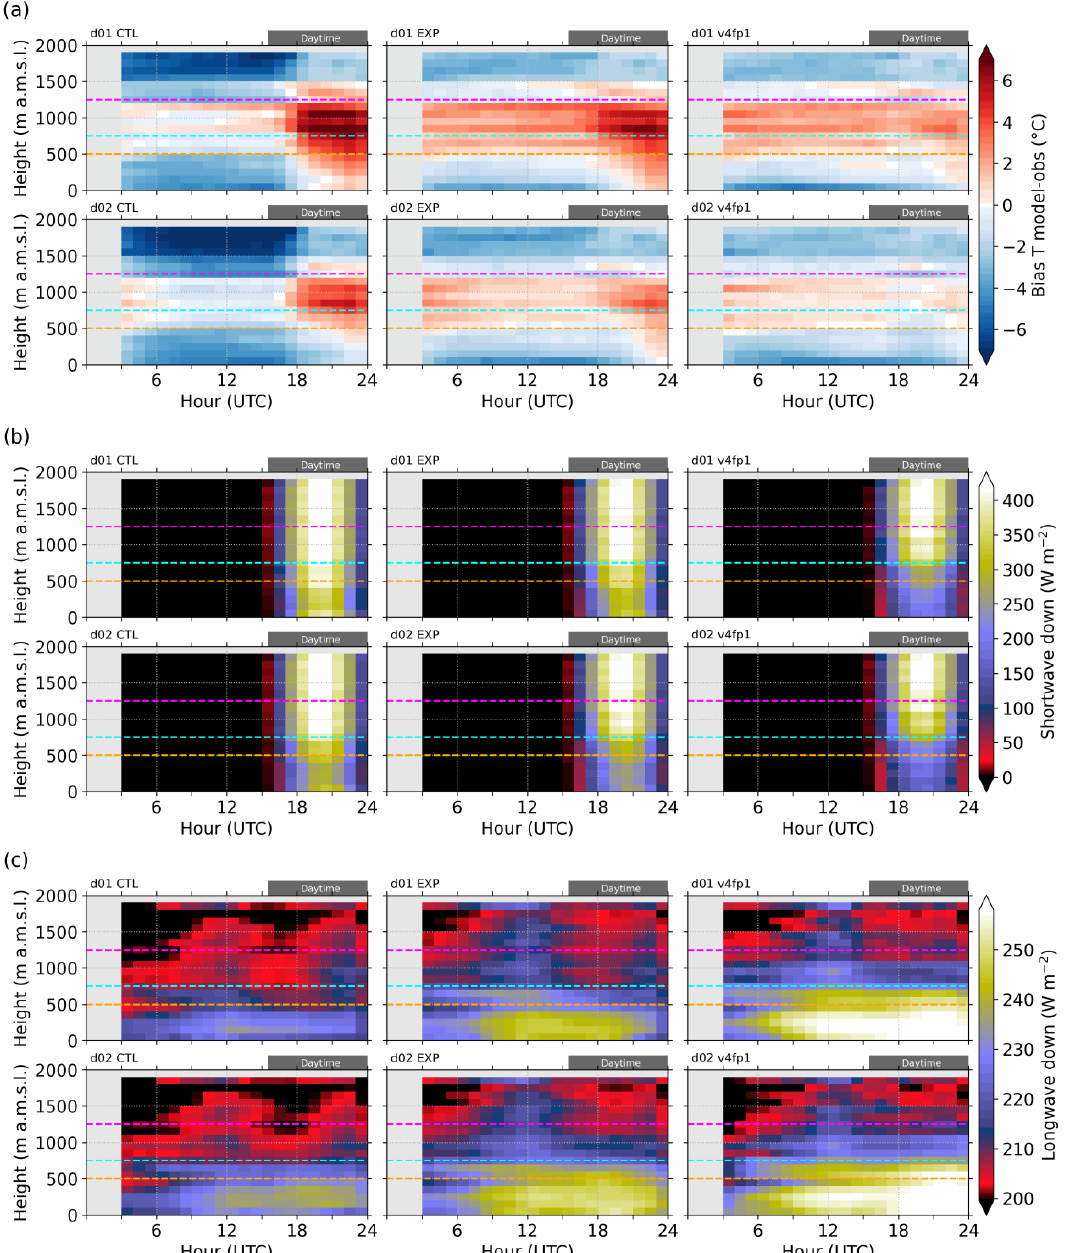
Figure 6. Twenty-four-hour composites of (a) near-surface temperature ( T ) bias, (b) shortwave downward radiation flux, and (c) longwave downward radiation flux averaged over the CAP period (13–16 January). Before calculating the composites, the temperature bias and radia- tion fluxes are computed at the location of the individual surface stations and then averaged over 100m height bins. The horizontal dashed lines indicate different height levels with colors corresponding to the terrain contours in Fig.